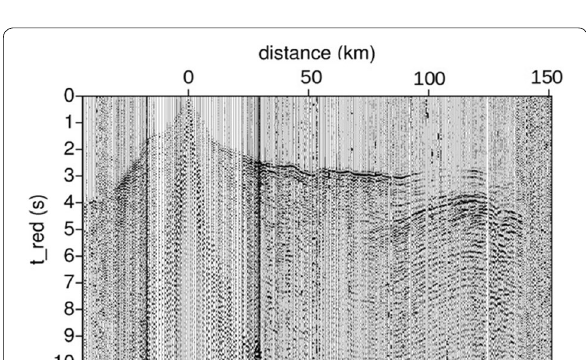
Fig. 8 A shot gathered on onshore Makran. The crustal phase Pg can be observed up to 130 km. Note the strong overcritical reflections (Px) from 80 to 140 km. Y -axis is reduced time ( V red processing included only band pass filtering (2–10 Hz) and